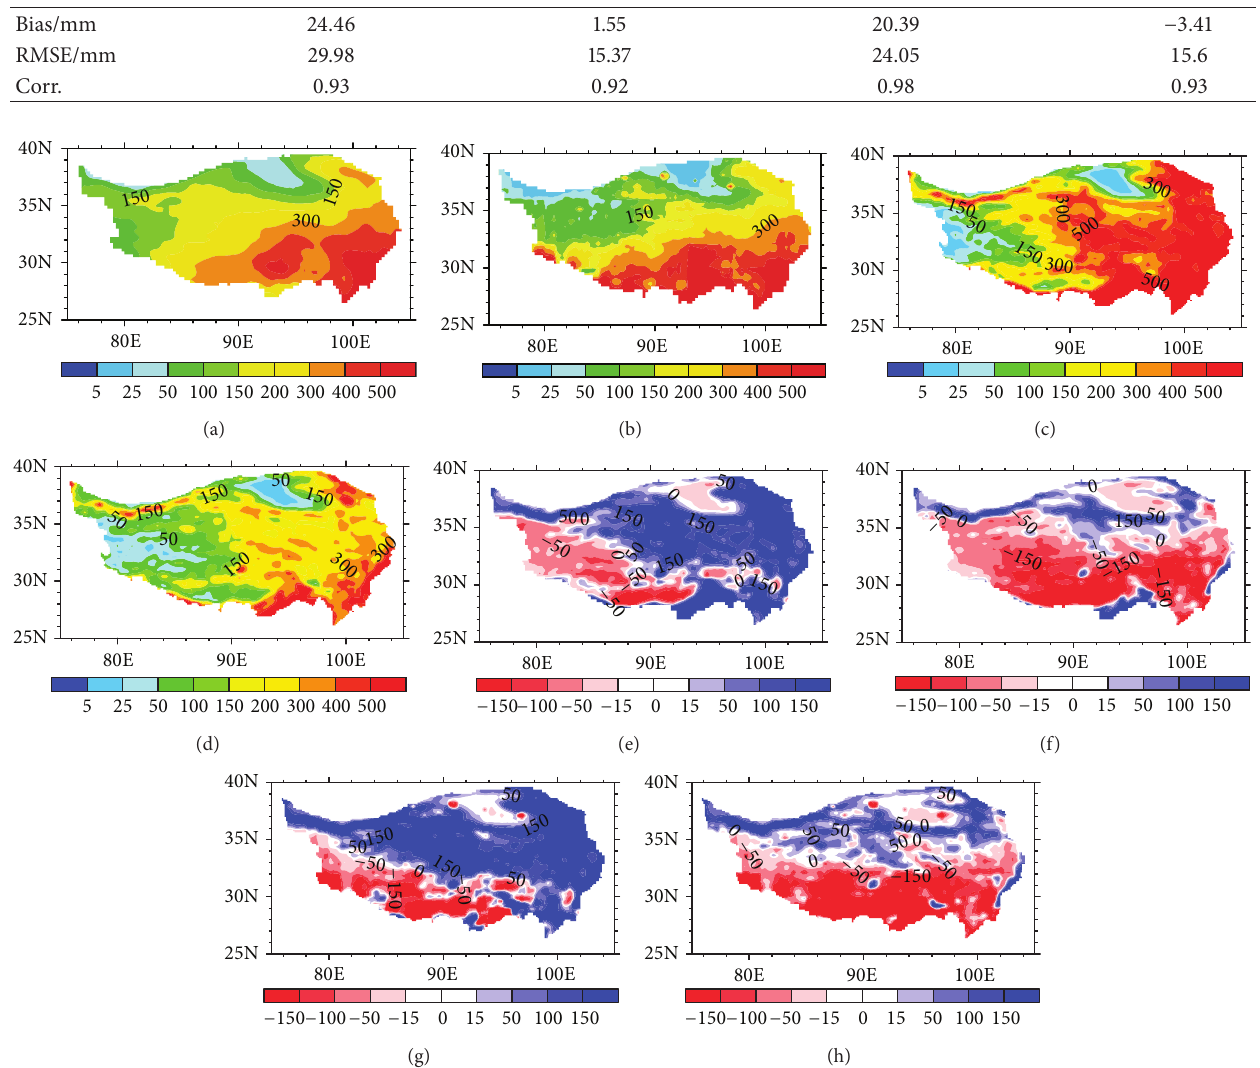
Figure 3: Summer precipitation distribution over the TP based on (a) CN05, (c) BATS, (d) CLM, (e) BATS minus CN05, and (f) CLM minus CN05 during 1992–2001 and (b) TRMM, (g) BATS minus TRMM, and (h) CLM minus TRMM during 1998–2001 (units: mm).